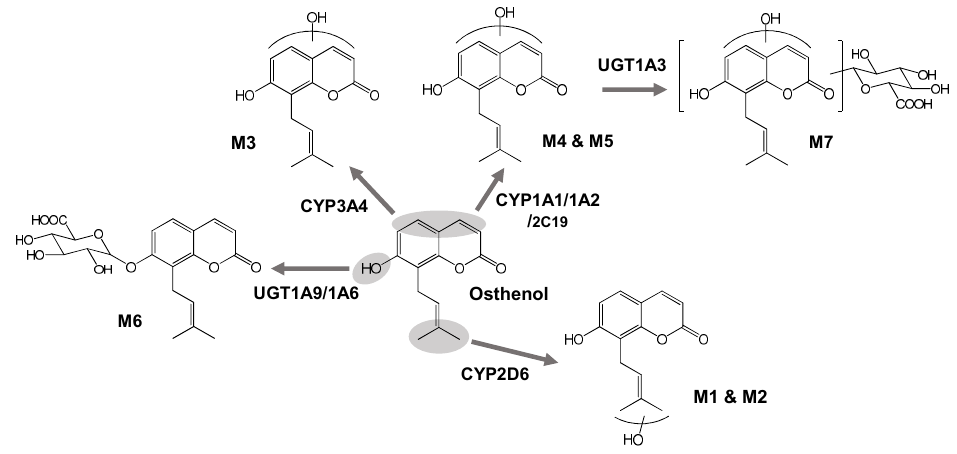
Figure 6. Postulated metabolic pathways of osthenol in human liver microsomes.